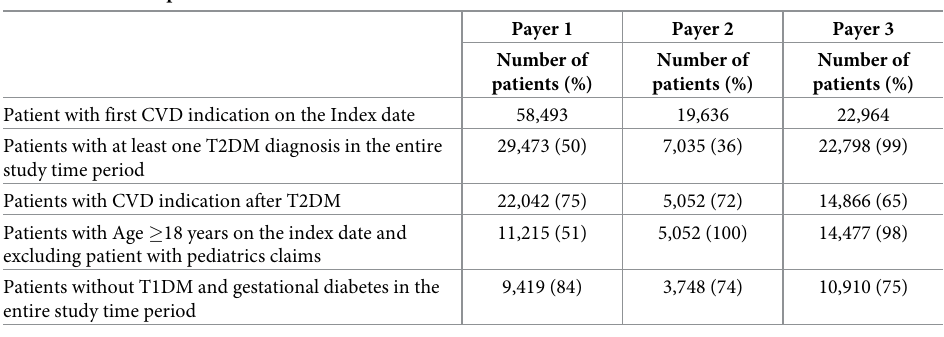
Table 1. Patient disposition.